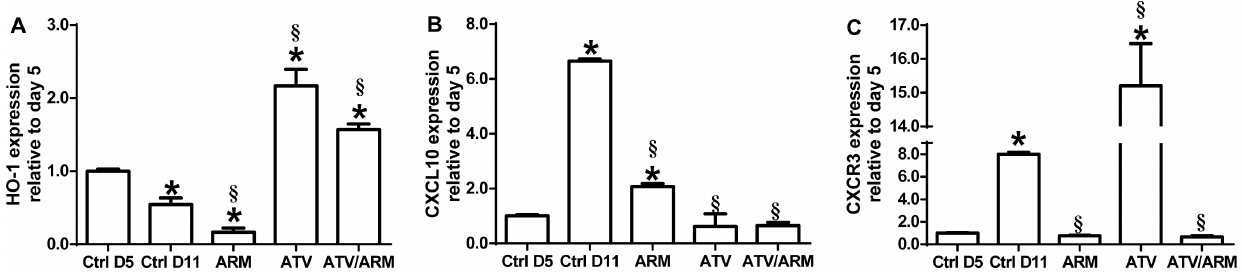
Figure 7. mRNA expression of HO-1 (A), CXCL10 (B), and CXCR3 (C) in whole brain homogenates of control, ARM, ATV, ATV/ARM- treated P.berghei ANKA-infected mice ( n =5 per group). Expression, measured by real-time PCR on day 11 post infection, is relative to the mean expression value in untreated mice day 5 post-infection brain samples and normalized on HPRT values. Treatment with ATV or ATV/ARM increased HO-1 expression and decreased CXCL10 expression in P. berghei ANKA-infection mice brain tissue. Columns and bars represent means 6 standard error. Mean expression values were determined to be significantly different using one-way ANOVA with Holm-Sidak post-tests method for all pairwise multiple comparison. A p value of , 0.05 was considered significant. Asterisks (*) denote statistically significant change compared with ctrl D5 and section sign ( 1 ) denote statistically significant change compared with ctrl D11. Note the different scales used on each graph. Ctrl=control; D=day; ARM=artemether;